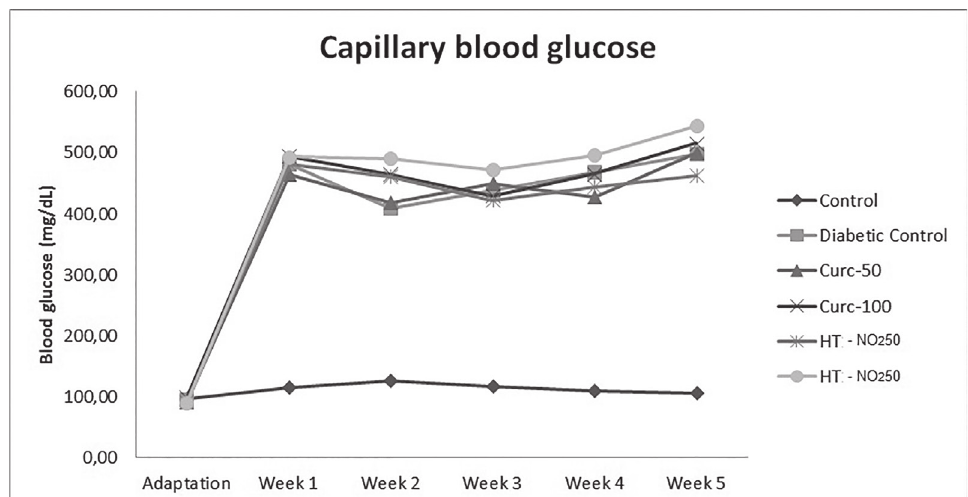
-50 = 2 -100 = group HTNO -100, diabetic, HTNO 2 2 2